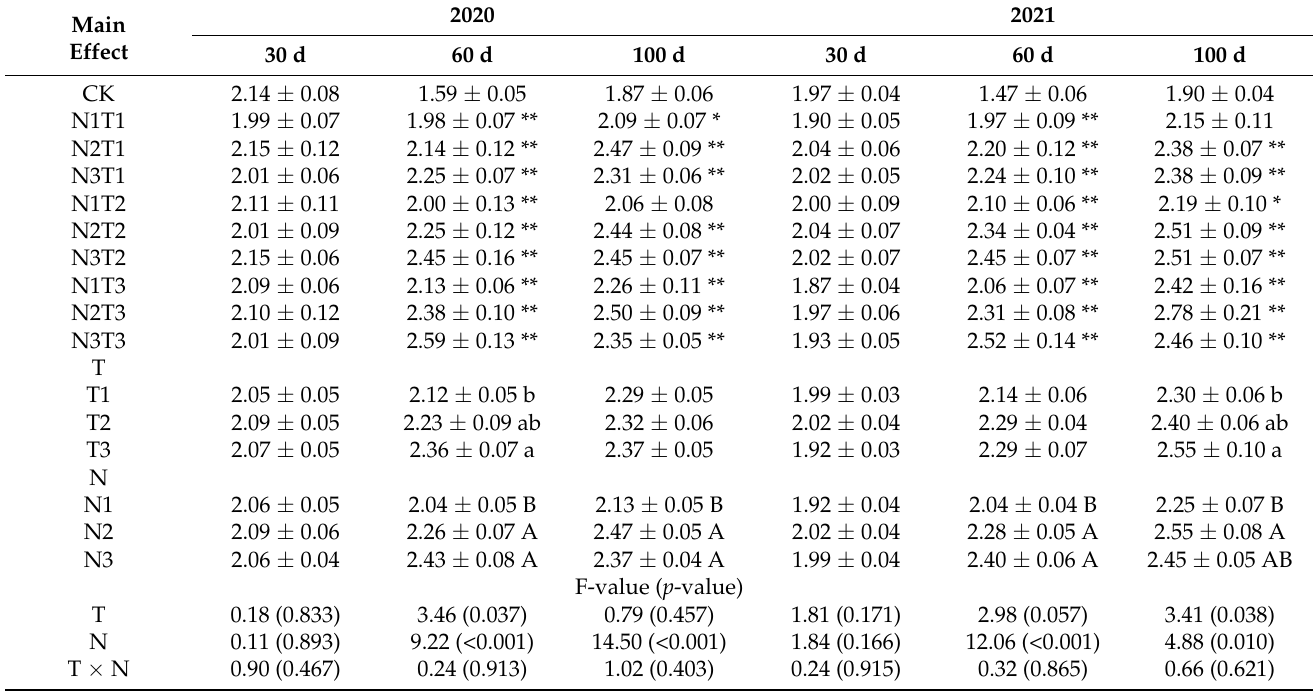
Table 8. Response of tomato water use efficiency of leaves (WUE L , mmol CO 2 mol − 1 · H 2 O) to different urea types and N application rates in the